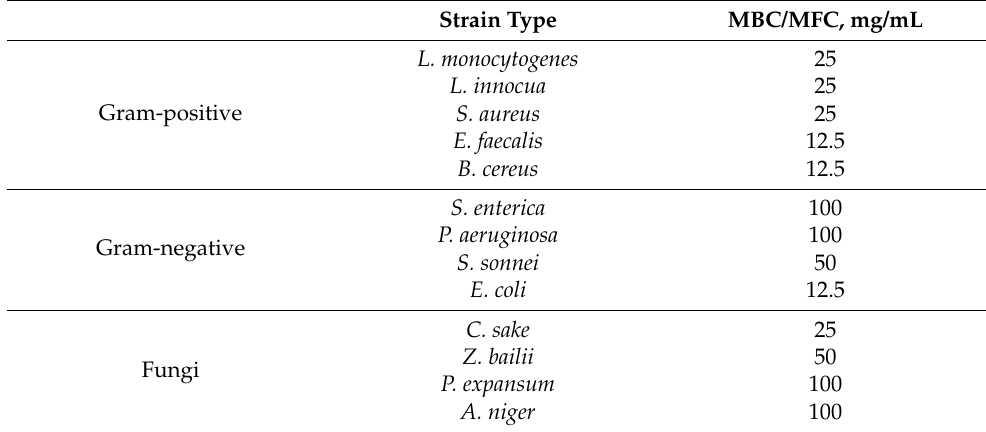
Table 4. MBC/MFC of the blackberry